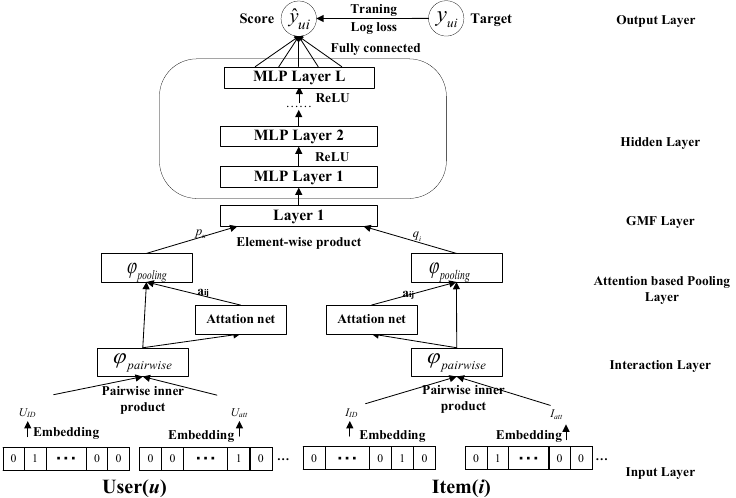
Figure 1. Information fusion-based deep neural attentive matrix factorization recommendation model